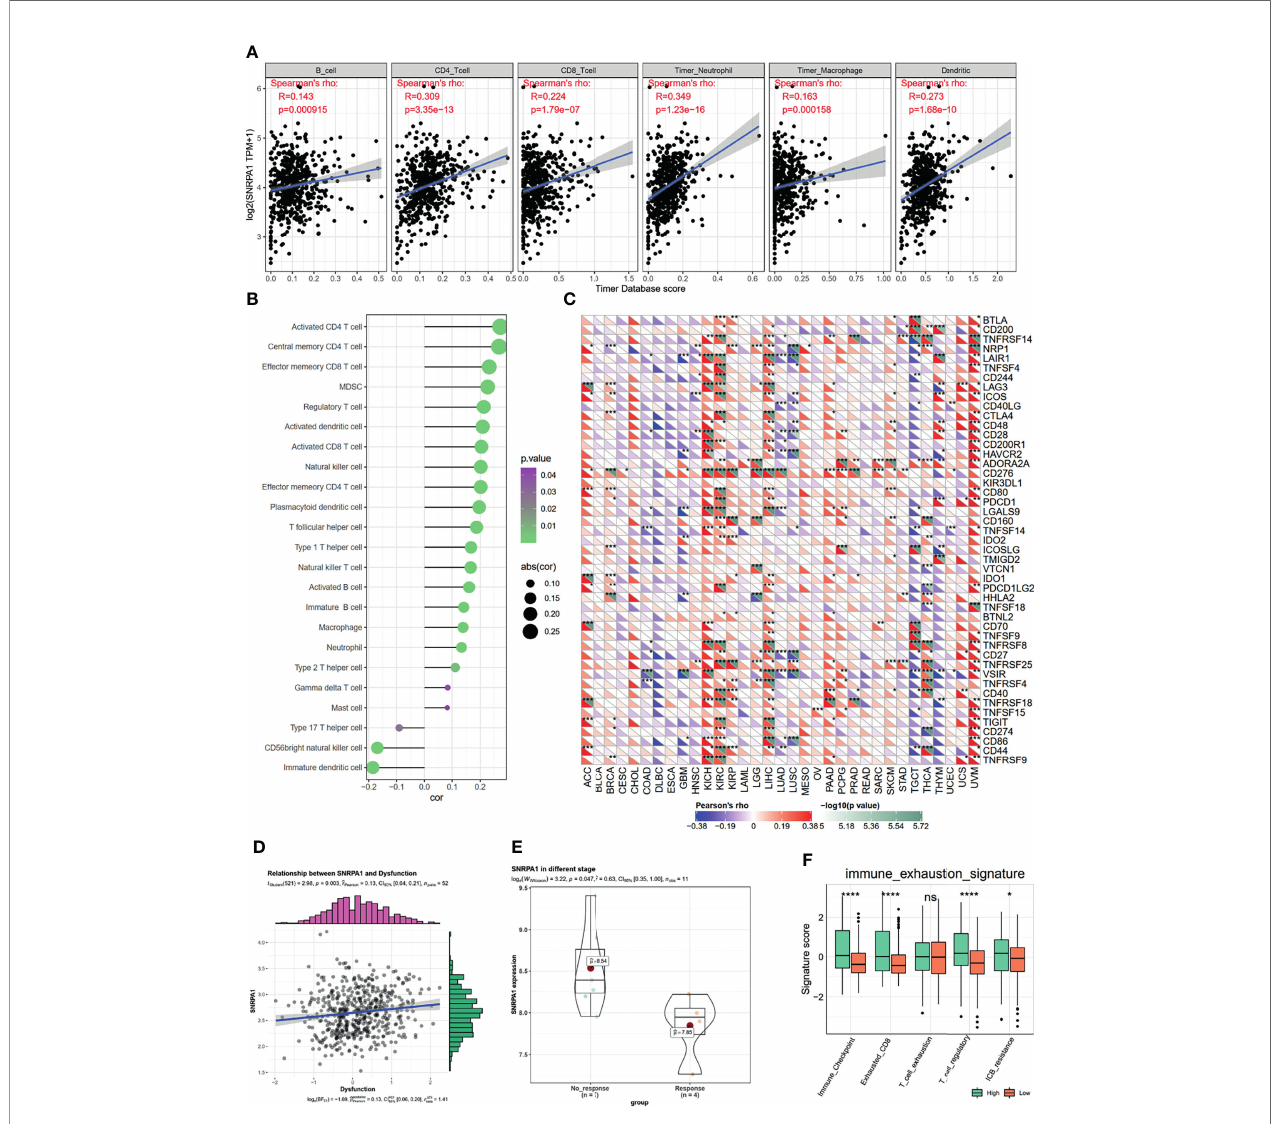
FIGURE 5 | Correlation between SNRPA1 and ccRCC immune microenvironment, immunotherapy. (A) SNRPA1 is associated with immune cell in fi ltration in ccRCC obtained from the TIMER database. (B) Associations between SNRPA1 expression and in fi ltration scores of 28 immune cells in ccRCC patients. (C) Correlation between immune check points and SNRPA1 expression in pan-cancer. (D) Correlation between immune dysfunction score and SNRPA1 expression in ccRCC. (E) SNRPA1 expression in ccRCC patients ’ response or no response to anti-PD-1 therapy. (F) Different enrichment scores of immune exhausted scores in SNRPA1 high and low ccRCC patients. *p < 0.05, **p < 0.01, ***p < 0.001, ****p value is too small and is close to zero. ns, p >